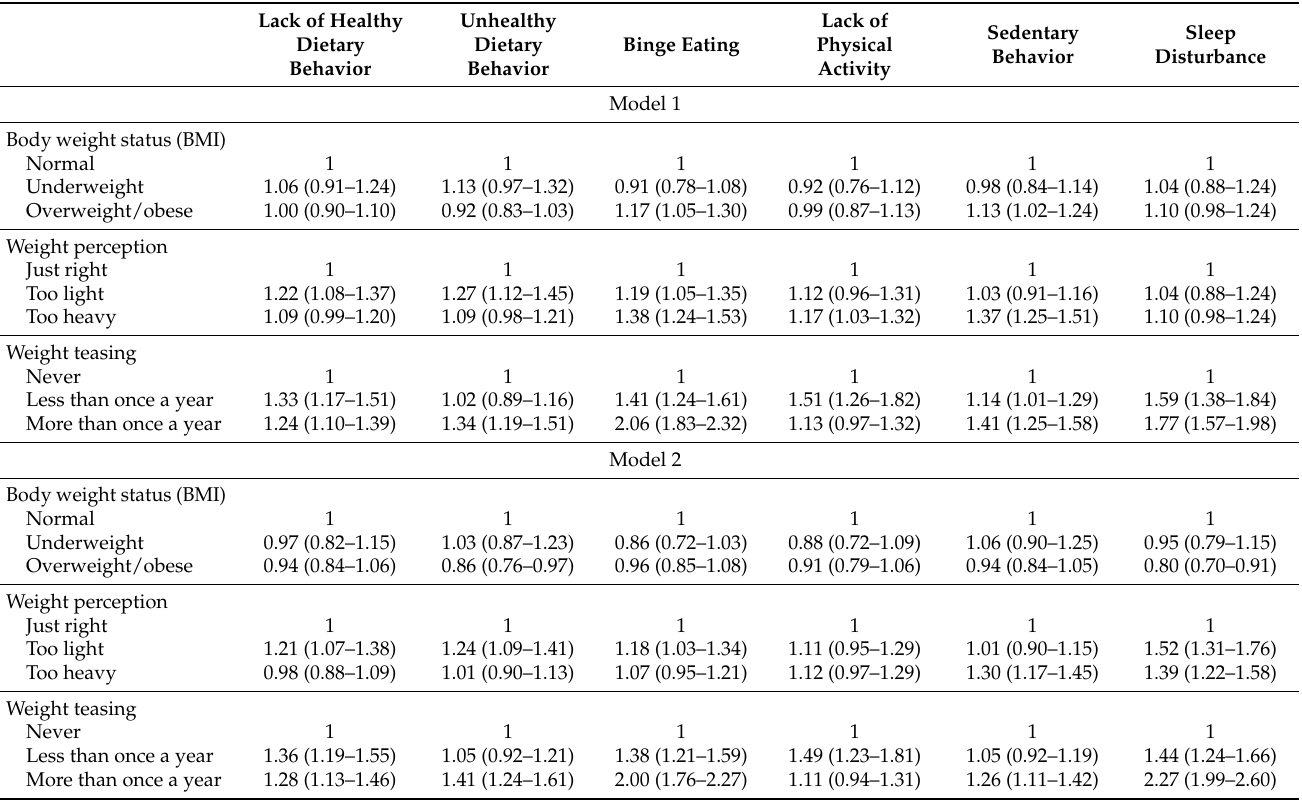
Table 3. The relationship between three kinds of weight-related statuses and six health behaviors OR